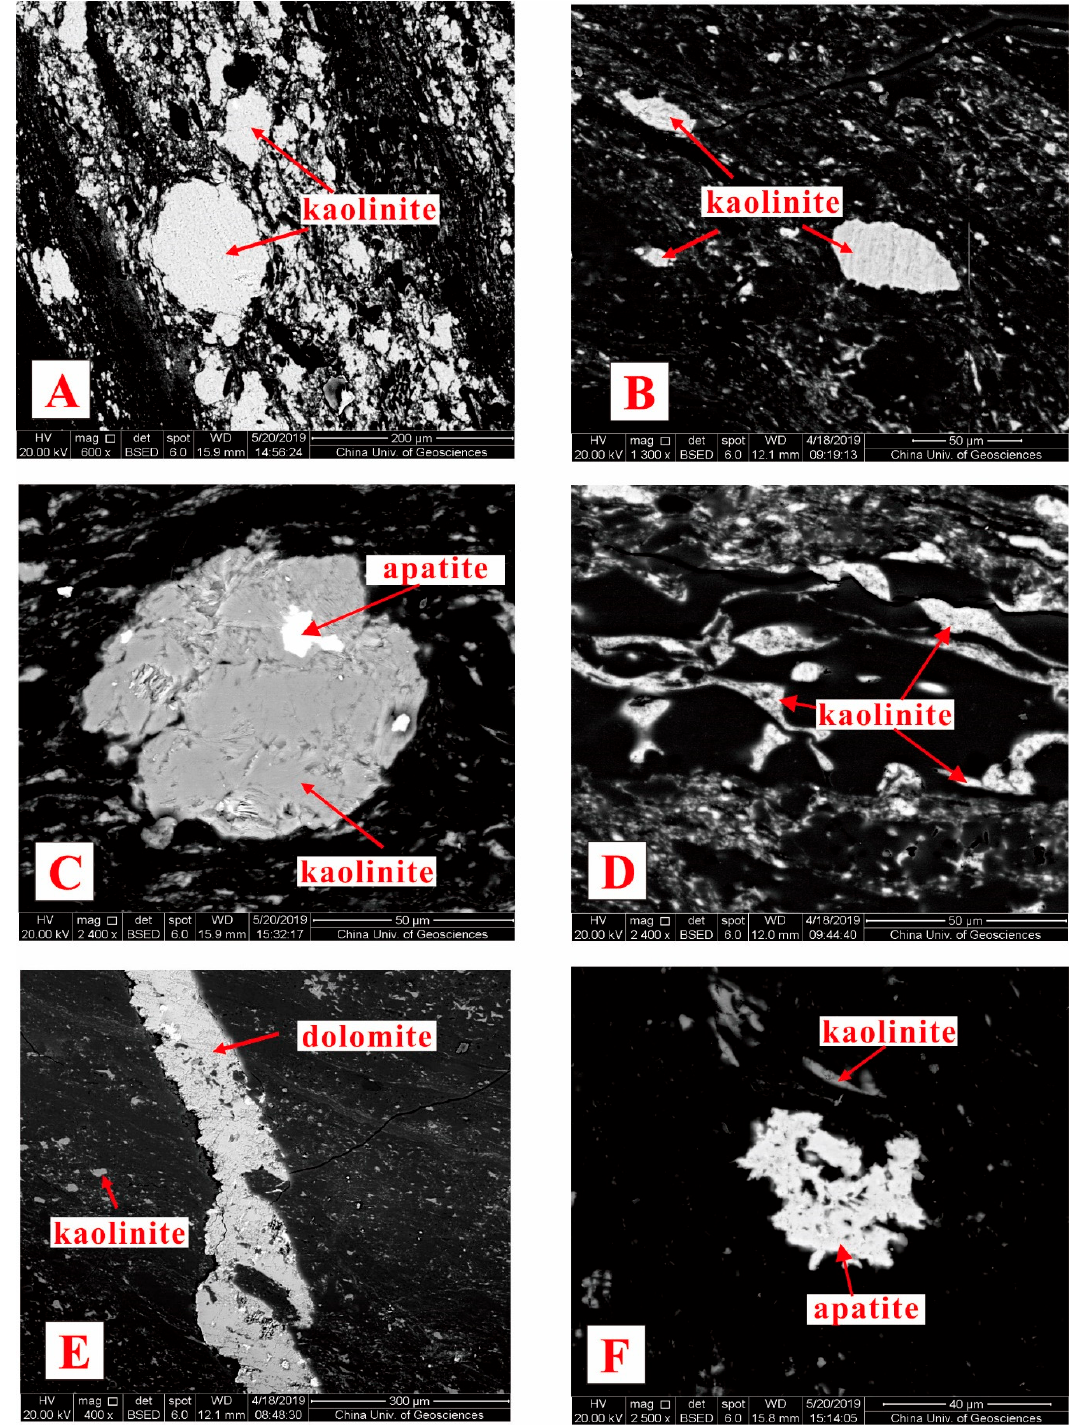
Figure 4. SEM back-scattered images of kaolinite, apatite and dolomite in PR-4-6. ( A , B ) dispersed kaolinite particles or kaolinite lenses; ( C ) apatite filling cavities of kaolinite; ( D ) cell-filling kaolinite; ( E ) fracture-filling dolomite; ( F ) apatite fillings pore/cavity of organic matter.